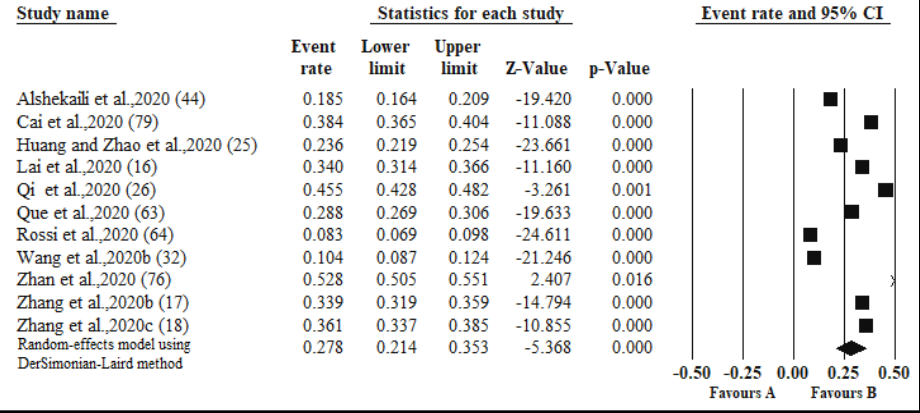
Figure A1. Forest plot for the studies on the prevalence of insomnia among healthcare workers. The squares and horizontal lines correspond to the study-specific event (anxiety) rates and 95% confidence intervals (CIs). The diamond represents the pooled prevalence and 95% CI of the overall population. The overall pooled insomnia using a random effects DerSimonian-Laird method was 27.8% (95% CI: 21.4–35.3).